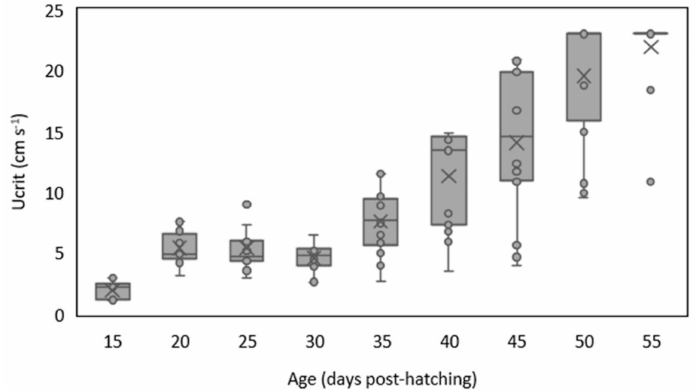
Figure 3. Variation of critical swimming speed (U crit ; cm s − 1 ) for white seabream Diplodus sargus (Linnaeus, 1758) larvae along ontogeny (15, 20, 25, 30, 35, 40, 45, 50, and 55 days post-hatching). The lines inside the boxes represent the median, × represents the mean, the lower and upper box limits represent the 25 th and the 75 th percentiles, whiskers represent the standard deviation, while dots represent the outliers. Table 2. Spearman’s rank correlations ( ρ ) between white seabream Diplodus sargus (Linnaeus, 1758) larvae’s critical swimming speed (Ucrit) (A) and swimming endurance (B) with age (DPH—days post-hatching), total length (TL, mm), dry weight (DW, mg), nucleic acid concentrations (RNA, µ